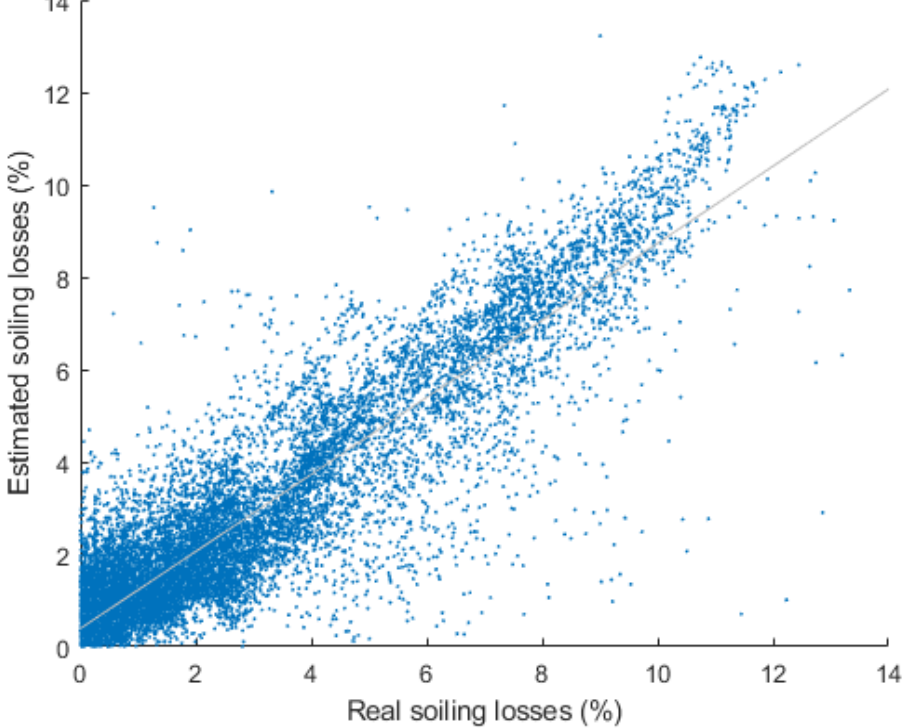
Figure 11. Scatter plot of actual vs. estimated losses with Isc.